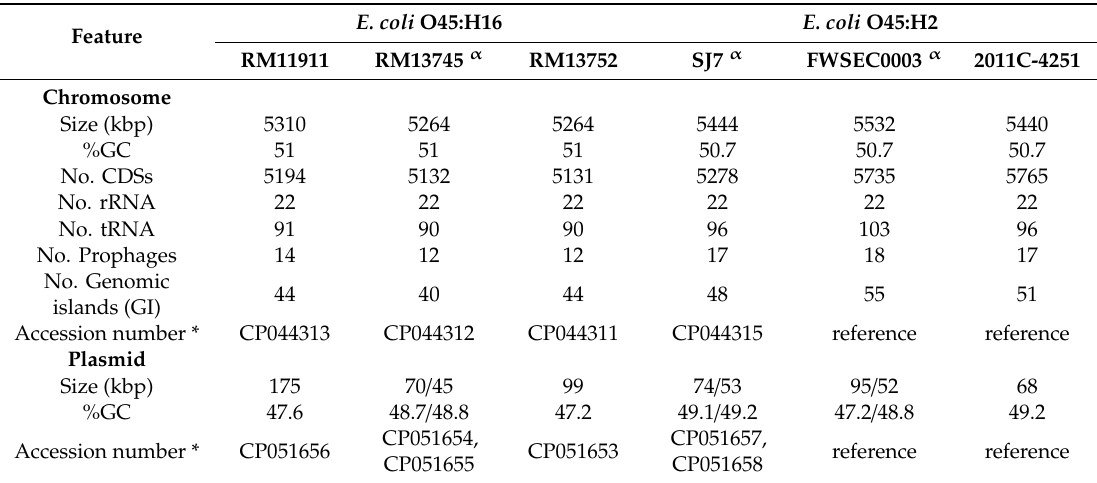
Table 1. Genomic features of the chromosomes and plasmids for six Shiga toxin-producing Escherichia coli (STEC) O45 strains analyzed in this study, including three environmental and three clinical